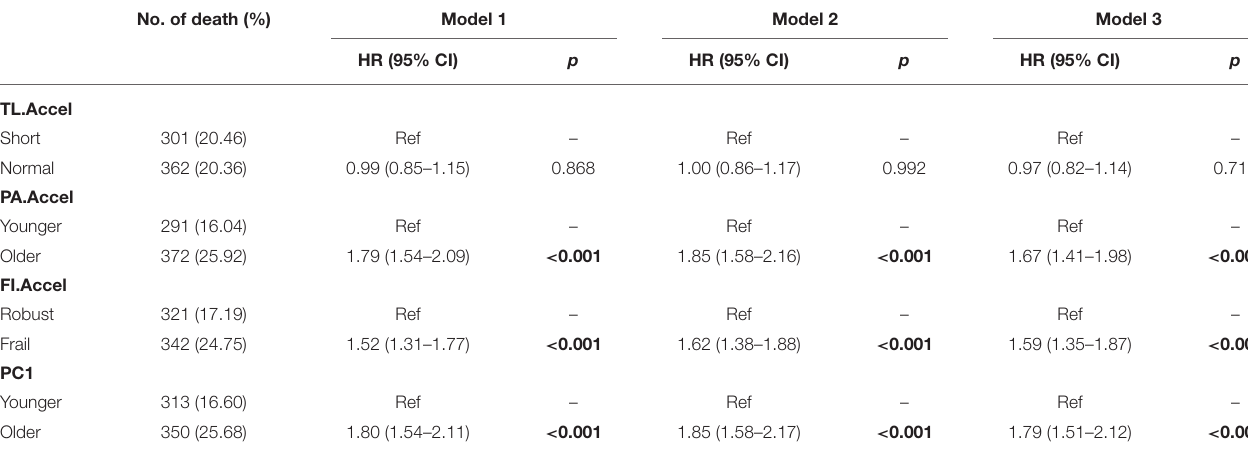
TABLE 2 | Associations of three aging measures with